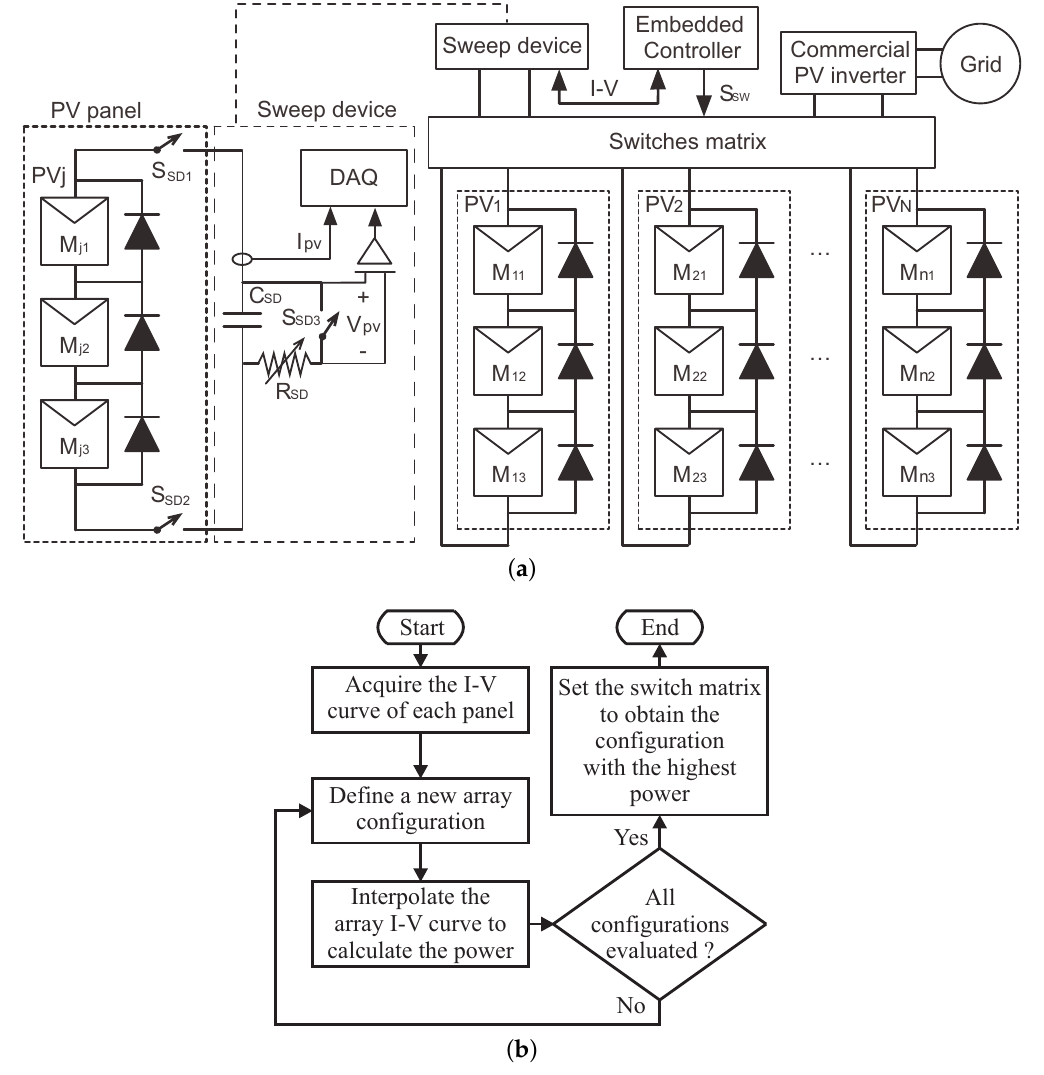
Figure 5. Proposed reconfiguration system. ( a ) General structure; ( b ) Controller